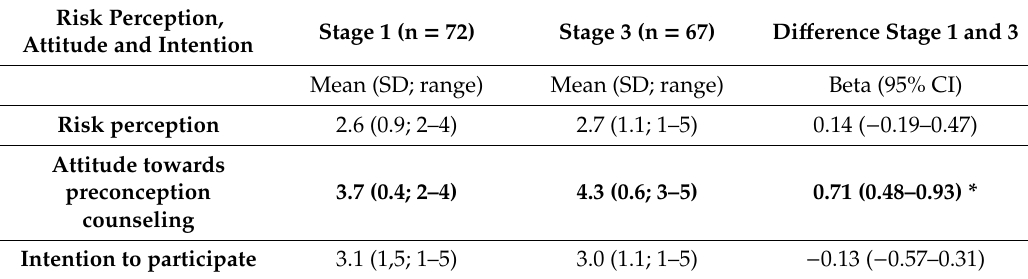
Table 7. Di ff erences between stage 1 and 3 in risk perception, attitude, and